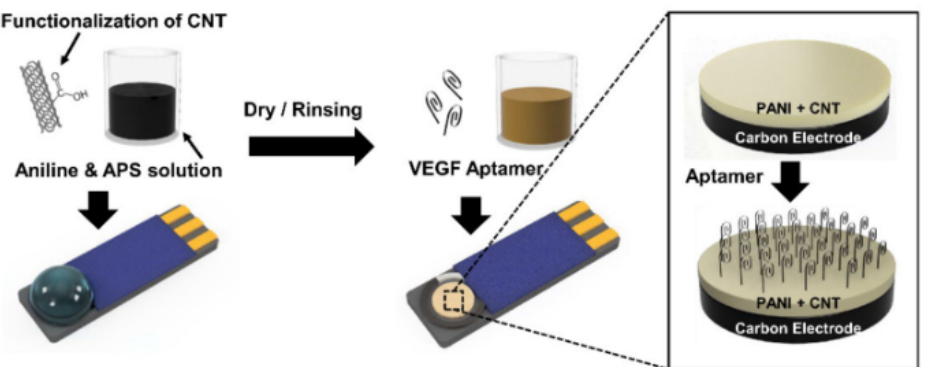
Figure 9. Construction of the VEGF aptasensor employing polyaniline/carbon nanotube (PANI/CNT) nanocomposite-coated screen-printed electrode. Adapted with permission from Park et al. [86] (under the terms and conditions of the Creative Commons CC BY License 4.0).